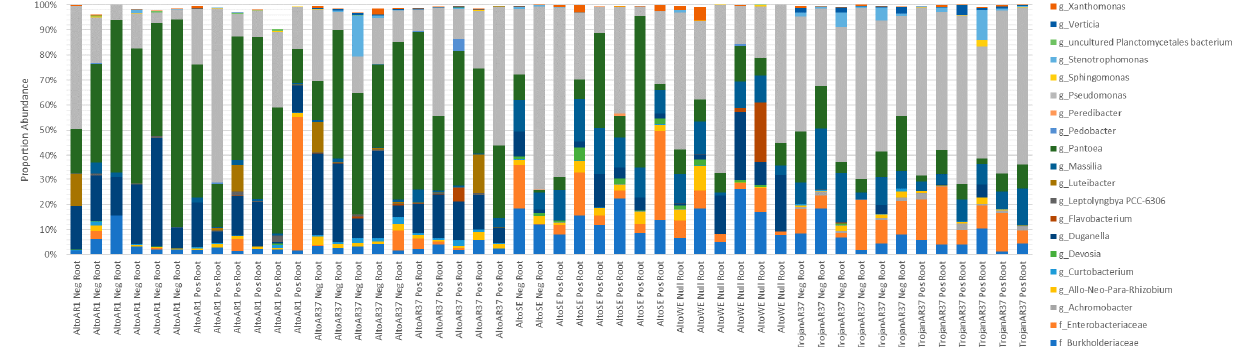
Figure 3. A comparison of genus level profiles of 41 dominant OTUs that each accounted for >1% of the total number of reads from Single Seeds.